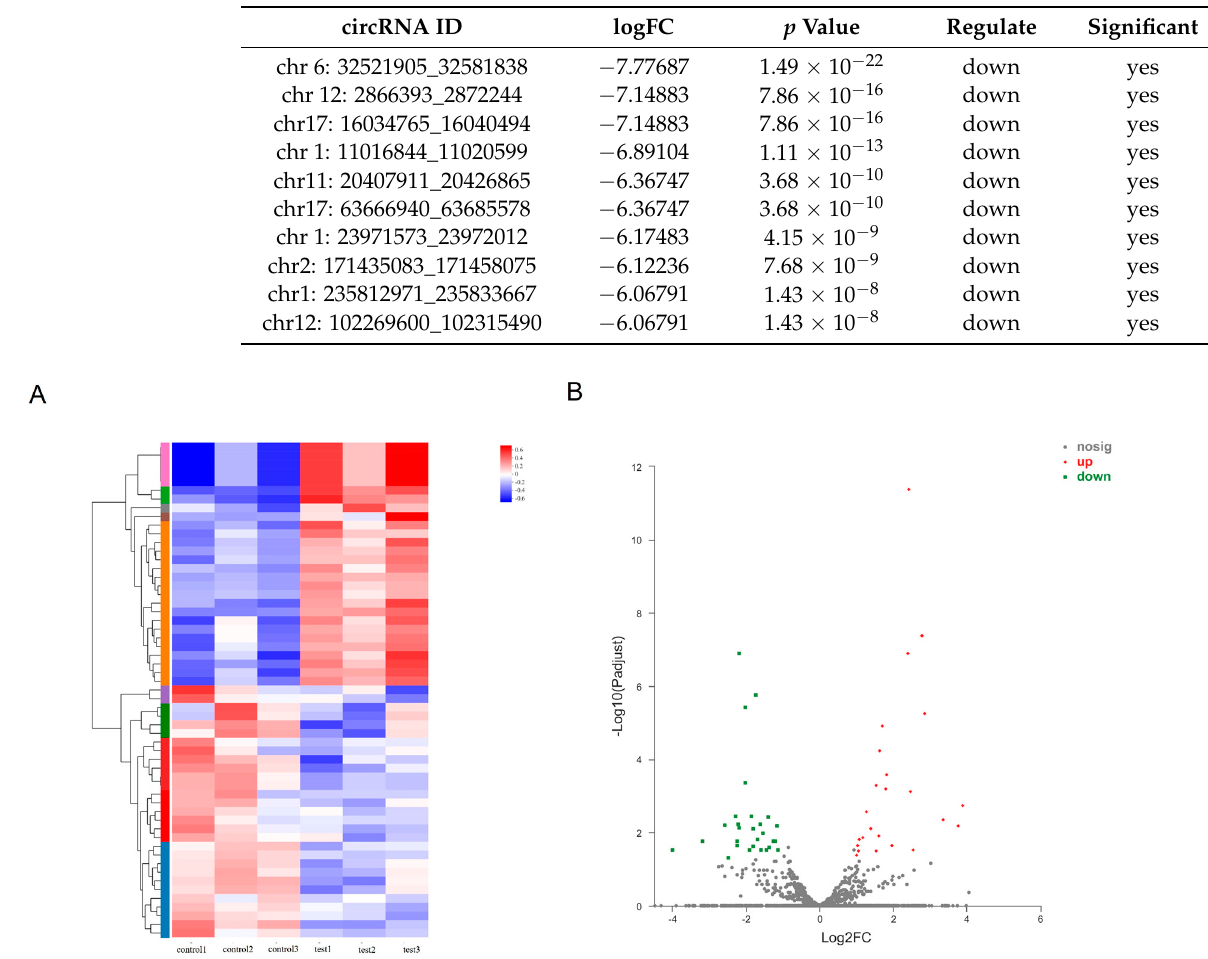
Table 2. The top 10 down-regulated circRNAs in leishmaniasis patients compared to healthy con- trol group.